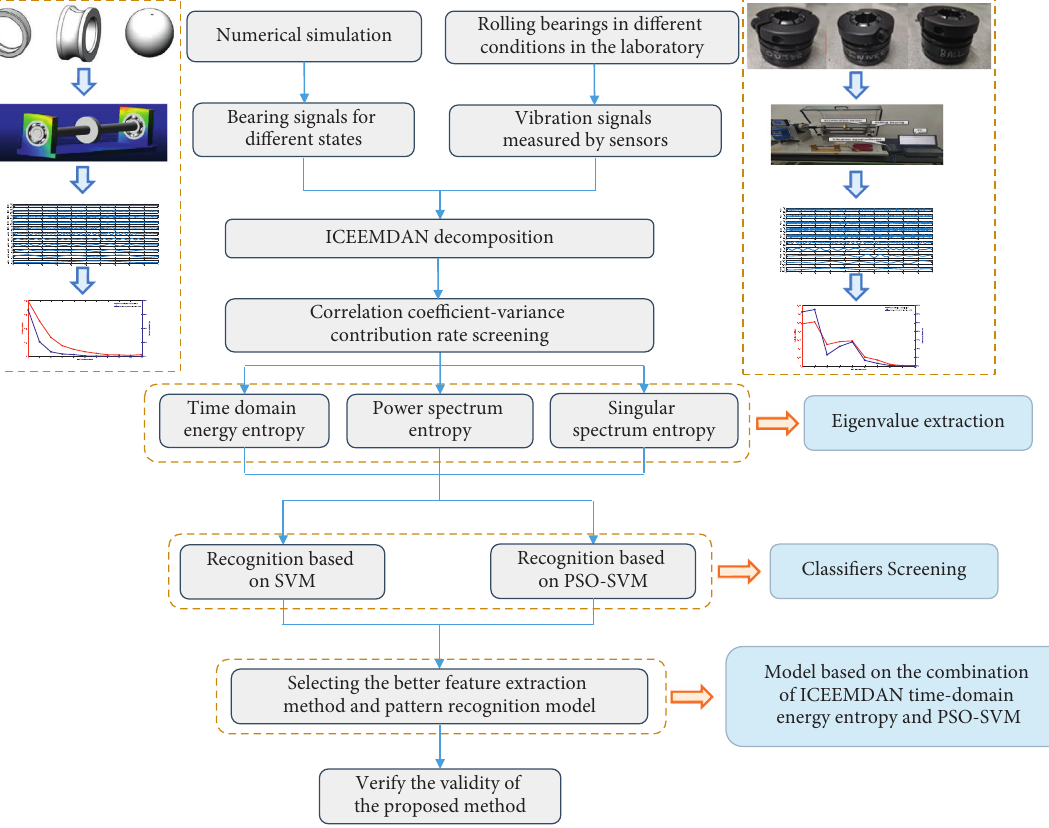
Figure 1: Research workflow. Table 1: Geometry dimensions of deep groove ball bearing